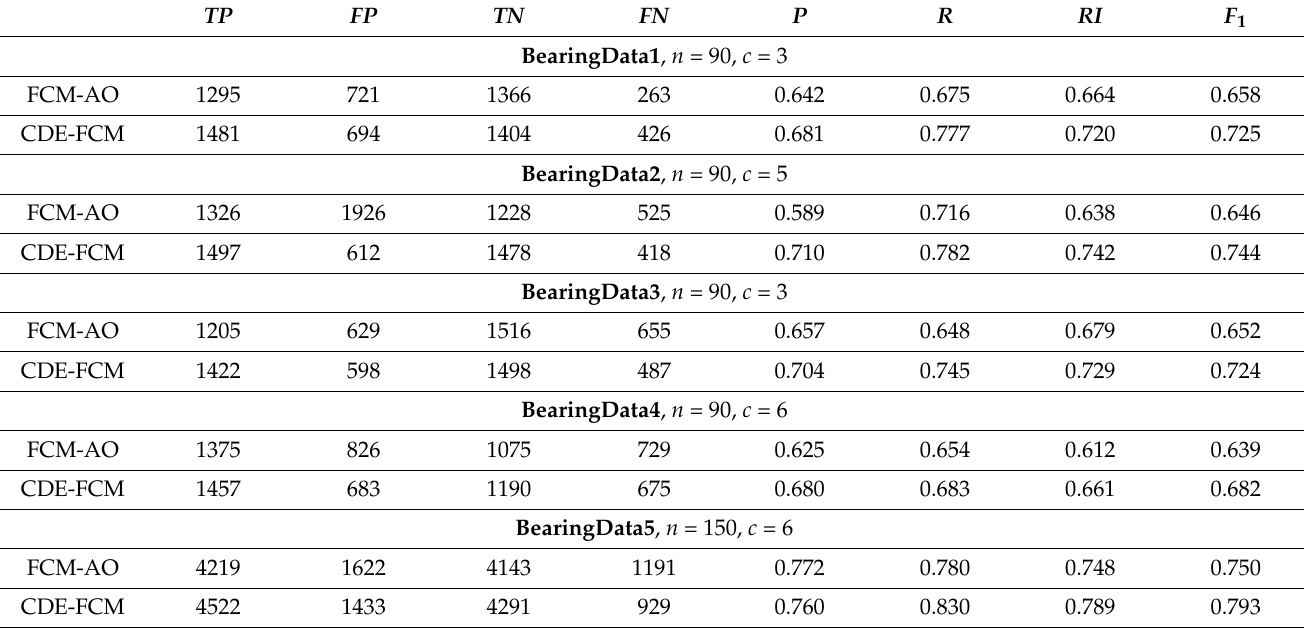
Table 10. Comparative evaluation of FCM-AO and CDE-FCM for five bearing fault